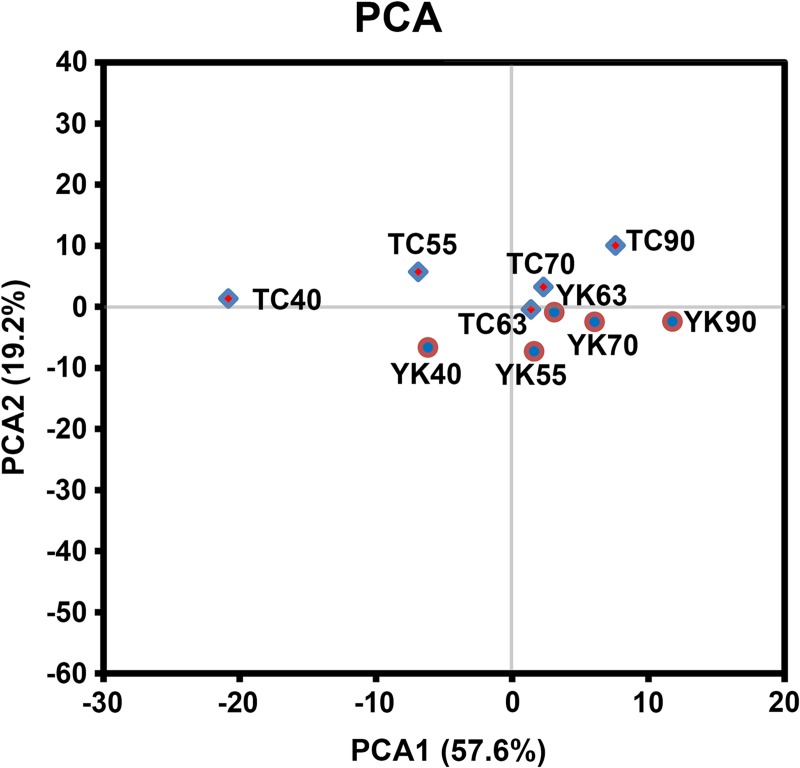
Principal component analysis (PCA) plot of sequencing data in the ten libraries.Clustering of the ten libraries. The rhombuses represent the Tongcheng and the circles represent the Yorkshire breed. TC: Tongcheng, YK: Yorkshire. Stages: 40, 55, 63, 70, and 90 days post coitum (dpc).